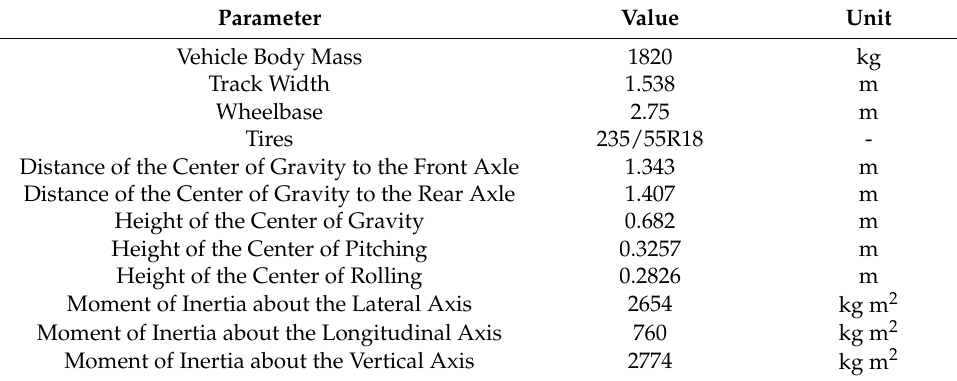
Table 1. Vehicle Parameters.